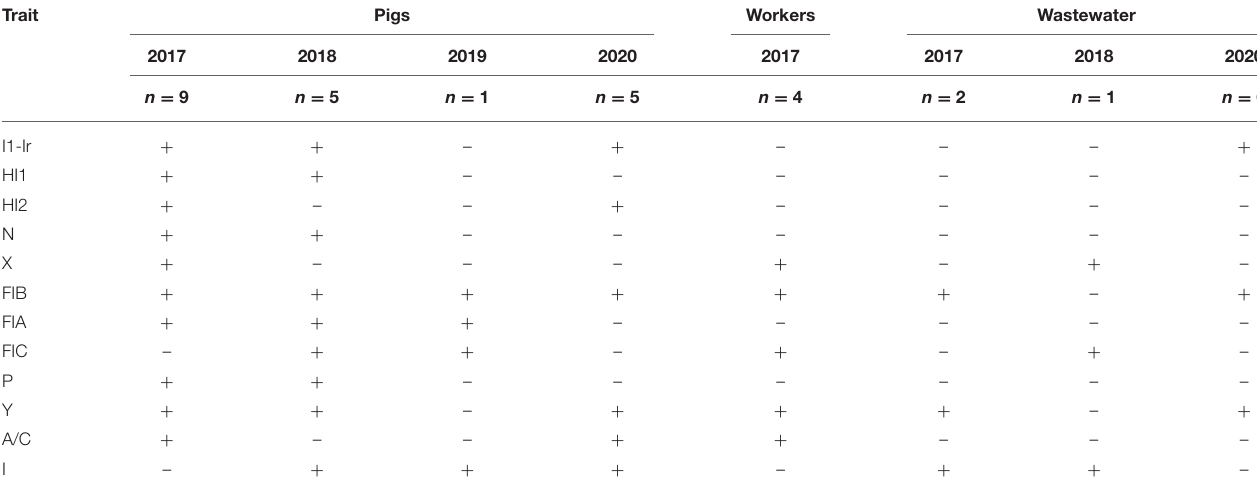
TABLE 3 | Plasmid replicon types detected in 33 colistin-resistant E. coli among the three categories of samples at each sample collection time. Trait Pigs Workers